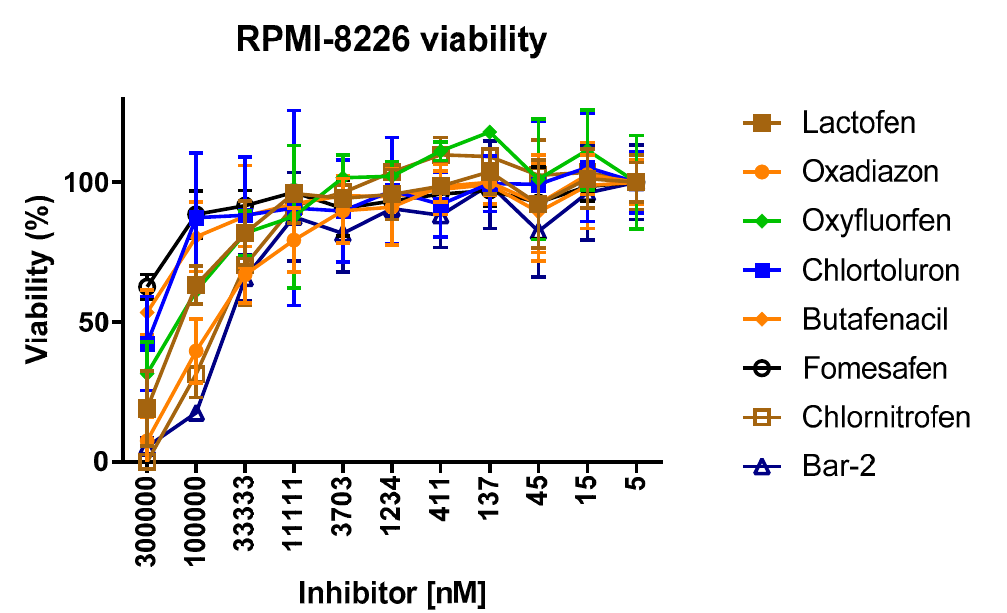
Figure 5. Cytotoxicity of the tested herbicides. Cells were treated with varying concentrations of herbicides for 48 h, and cell viability was determined using the MTT assay.